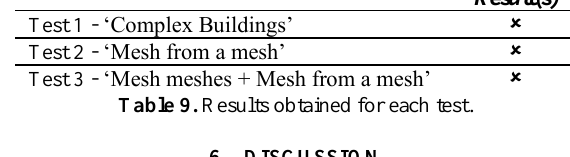
Figure 7: Reconstructed tall building (left to right: 100%, 80%, 75% and 20% point cloud density).